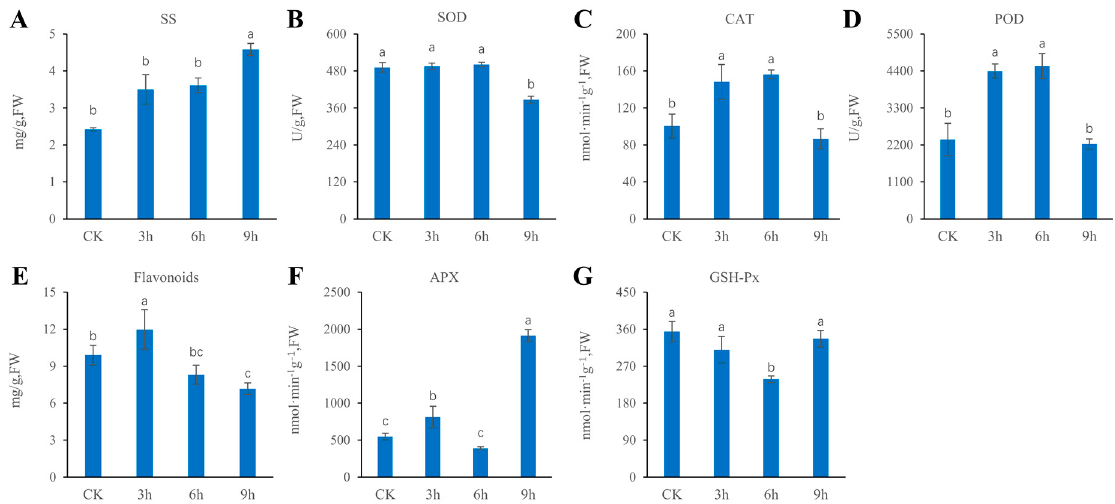
Figure 1. Effects of cold stress duration (CK, 3 h, 6 h and 9 h) on physiological indices of centipedegrass. ( A ) Soluble sugar content, ( B ) SOD activity, ( C ) CAT activity, ( D ) POD activity, ( E ) flavonoid content, ( F ) APX activity and ( G ) GSH-Px activity. Data are given as the mean ± SD (different letters indicate significant differences at p < 0.05 via Duncan’s test).